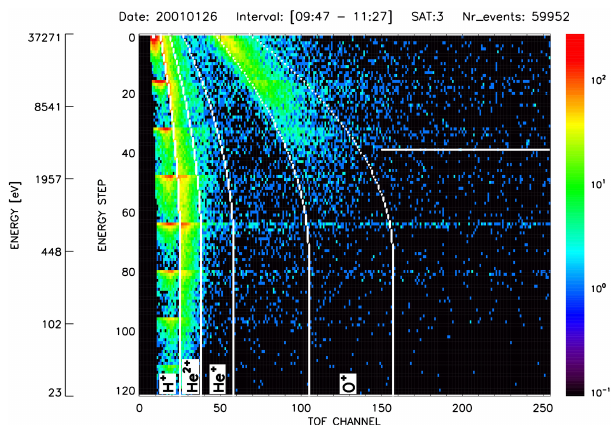
Figure 9. Raw events as a function of TOF and E/q for the 26 Jan- uary 2001